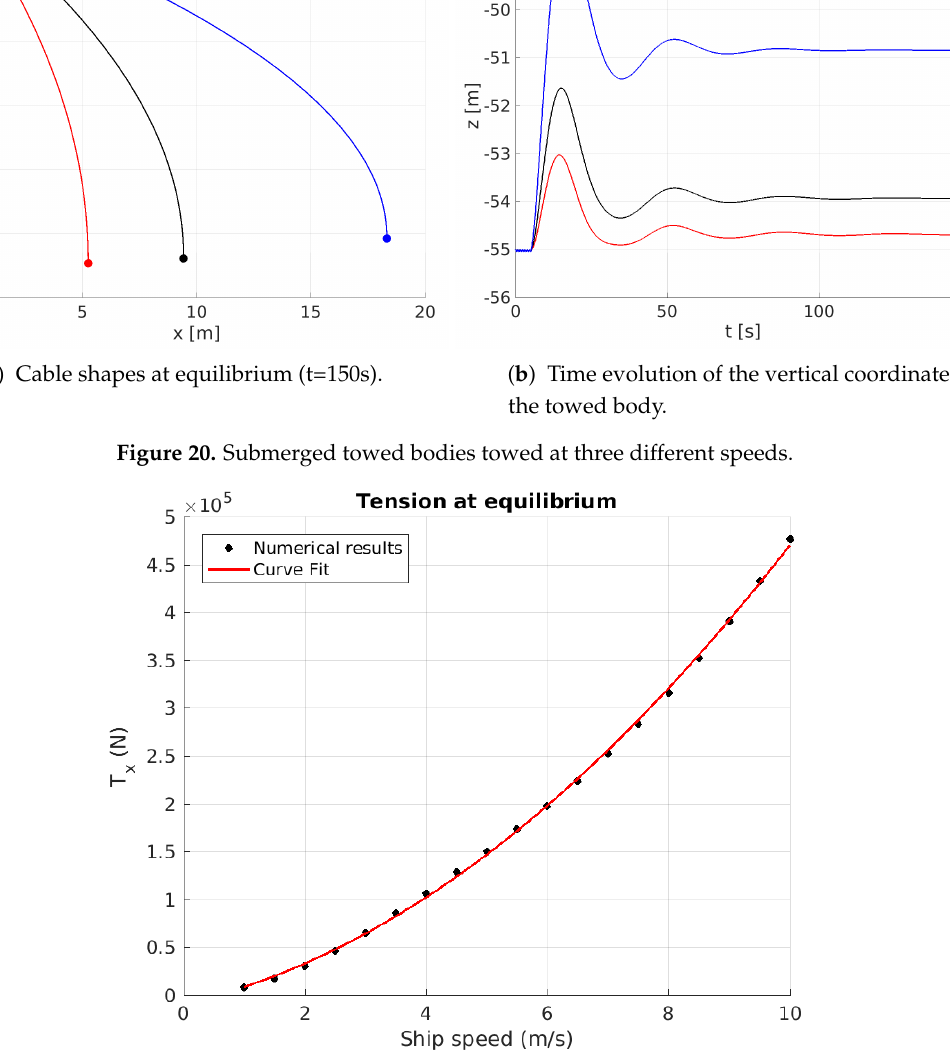
Figure 21. Dependence of the final horizontal tension at the fairlead with the ship